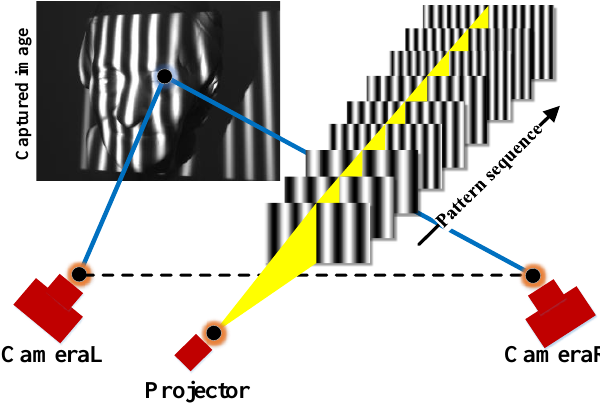
Figure 1. Measurement principle of the scanner.